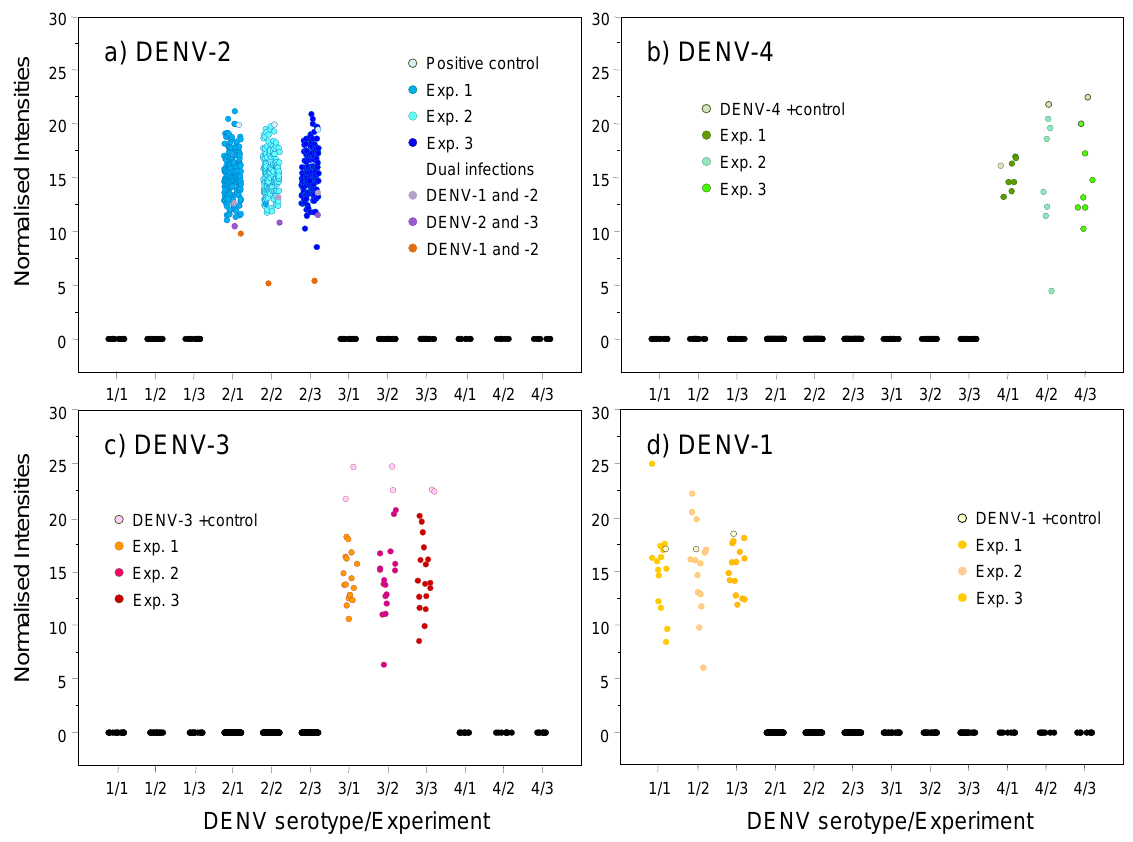
Figure 4. Samples were evaluated for the presence of DENV-1, -2, -3, and -4. Plots represent the normalised intensity for each sample in three different experiments. Each panel represents values for DENV-1 (Texas Red), DENV-2 (FAM), DENV-3 (Cy5), or DENV-4 (Yakima yellow). ( a ) Fluorescence for 162 DENV-2-positive samples, 1 positive control, and 3 dual infections positive for DENV-1 and -2, DENV-2 and -3, and DENV-1 and -2. ( b ) Seven DENV-4-positive samples and 1 positive control. ( c ) Seventeen DENV-3-positive samples and 2 positive controls. ( d ) Fourteen DENV-1-positive samples and 1 positive control. All positive samples yielded fluorescence intensities >0.2. Each experiment is represented by spots of different colours. Each spot represents the average fluorescence intensity of triplicate spots. Analysis was performed in S-Plus software [S-PLUS: Copyright 1988, 2007 Insightful Corp. Rev Date:Wed May 02 10:07:00 2007 Buil8052. Seria#: WTB00000001. Juan Burgueño. CIMMYT, INC;